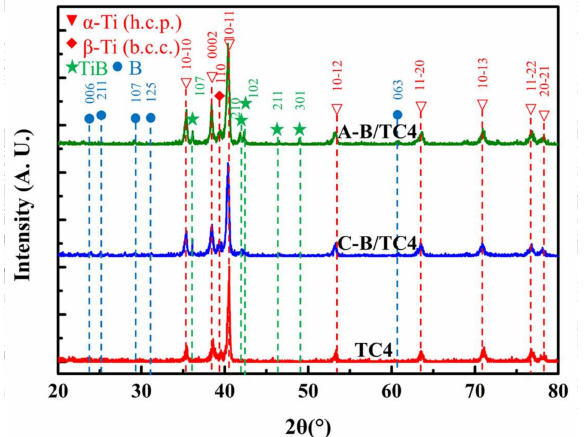
Figure 7. The XRD patterns of sintered